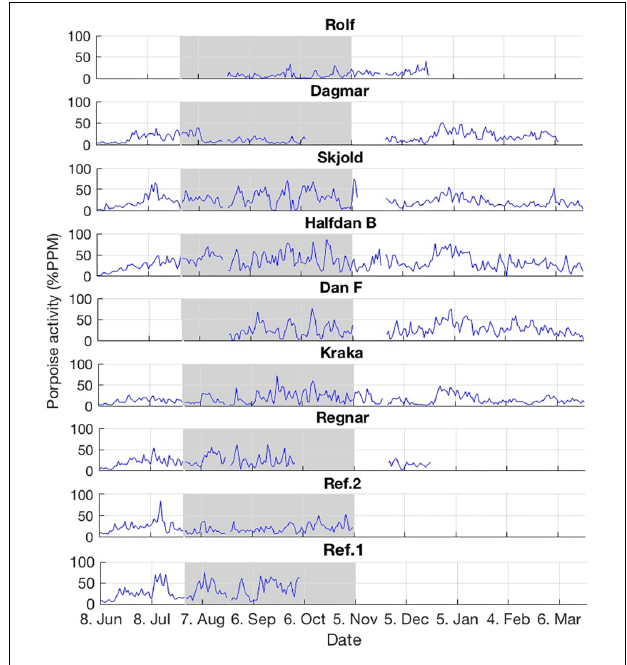
FIGURE 2 | Porpoise acoustic activity expressed as percent porpoise positive minutes per day (% PPM) for the nine stations during the entire study period June 2016–March 2017. The shaded gray time period indicates when the seismic survey was